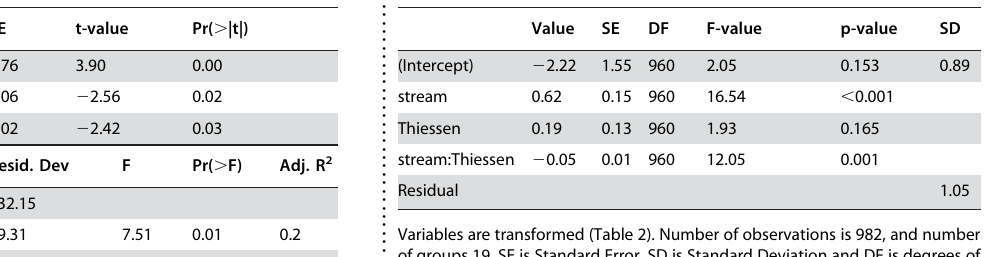
Table 4. Summary statistics of the regional generalized